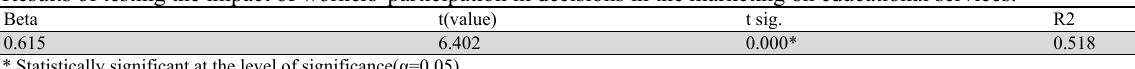
Results of testing the impact of workers' participation in decisions in the marketing on educational